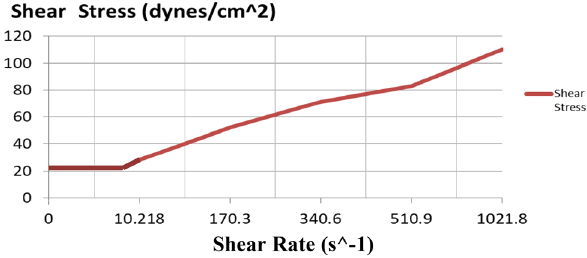
Fig. 31 Shear stress vs shear rate of optimized CMC–bentonite mud